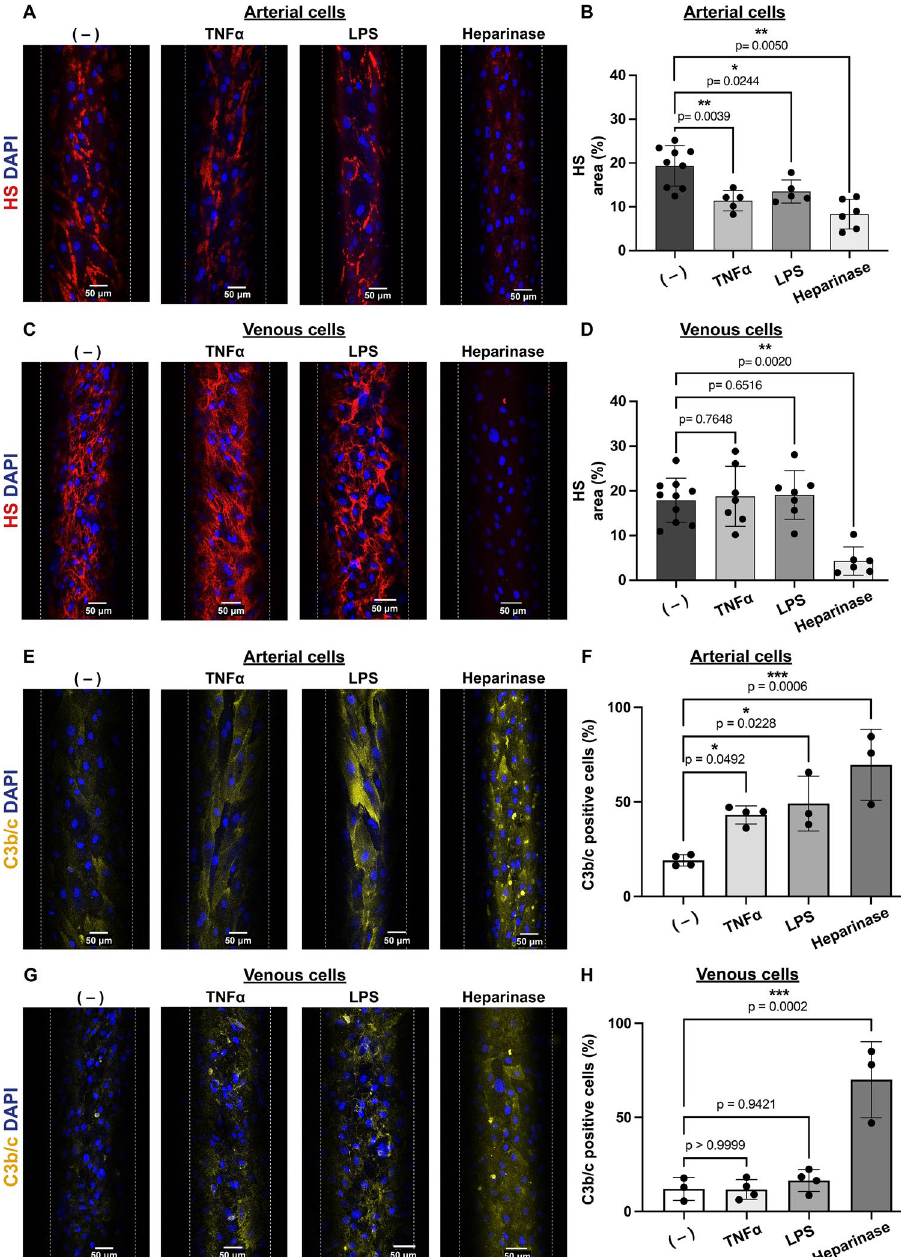
Figure 4. Unscathed heparan sulfate on venous cells after stimulation with TNFα or LPS prevents complement deposition. ( A , C ) Representative images of cells left untreated (−) or perfused with either 100 ng/ml TNFα, 100 μg/ml LPS or 5 U/ml heparinase (Heparinase). Heparan sulfate (HS) is shown in red, and nuclei in blue (DAPI). Scale bar: 50 μm. ( B , D ) Shedding of HS was quantified for each image (4 images/condition/ experiment) as the percentage of area positive for HS and normalized for the total number of cells/image. ( E , G ) Representative images of complement C3b/c on the cell surface of cells left untreated (−) or perfused with either 100 ng/ml TNFα, 100 μg/ml LPS or 5 U/ml heparinase (Heparinase). C3b/c is shown in yellow and nuclei in blue (DAPI). Scale bar: 50 μm ( F , H ) C3b/c deposition was measured as the percentage of C3b/c positive cells/ total number of cells/image (4 images/condition/experiment). Two-way ANOVA with Tukey and Bonferroni post-hoc test was used for statistical analysis. Data are from three or more independent experiments, 2–3 different porcine ECs donors and were analyzed using Fiji